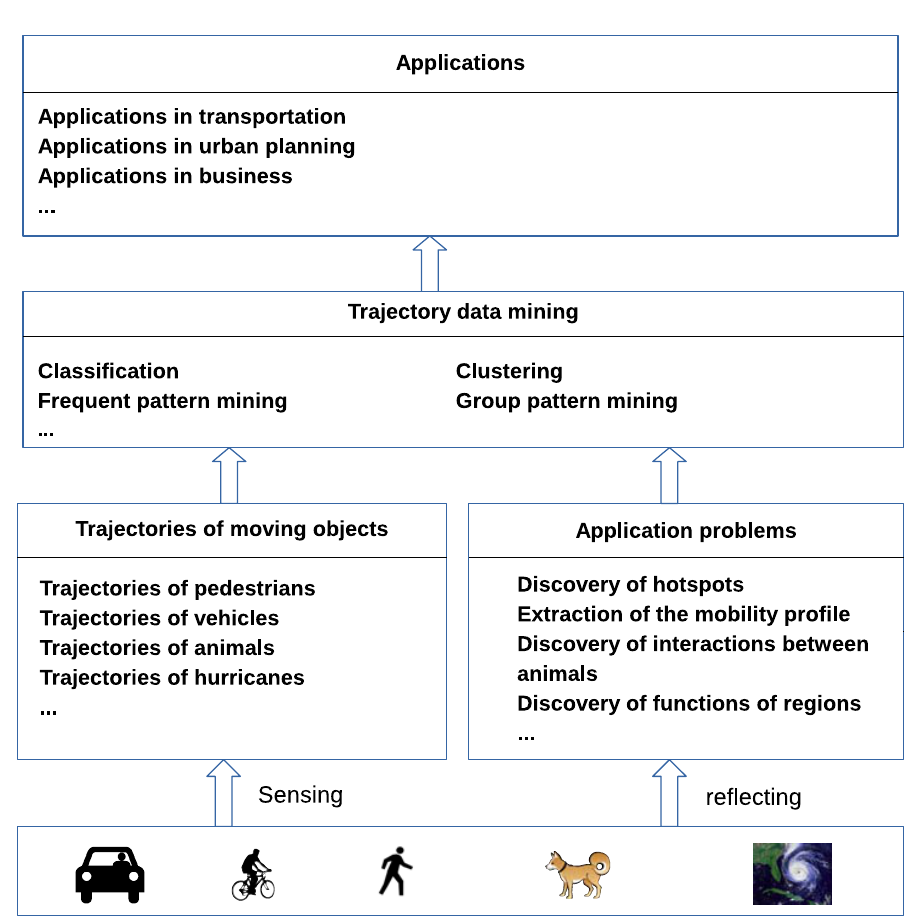
Figure 1: General framework of application-driven trajectory data